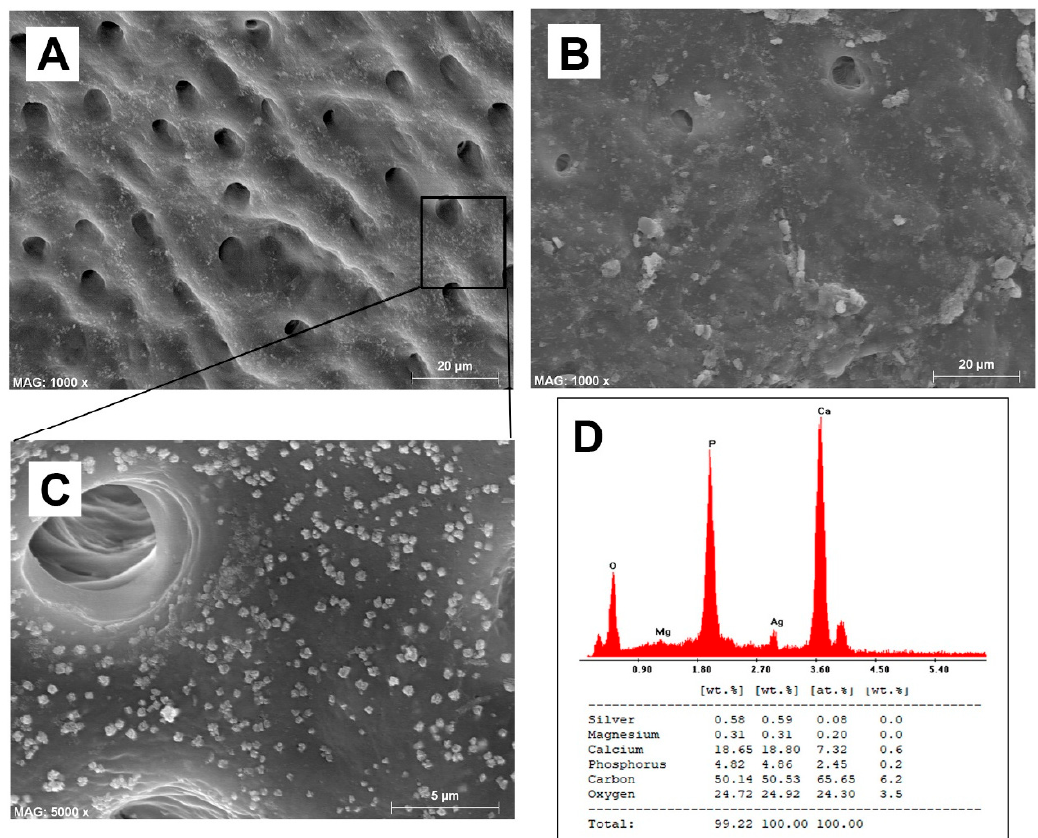
Figure 3. The effect of BioAKT on the apical part of the root canal dentin; the smear layer was well removed and most of the dentinal tubules exposed. ( B ) Note the effect of EDTA on the apical part of the root canal dentin where the smear layer was only partially removed, leaving most of the dentinal tubules still obliterated. ( C ) Higher magnification of image ( A ) where possible to observe the presence of nanometric mineral precipitations on dentin surface. ( D ) EDS analysis confirmed that the mineral clusters observed in image ( C ) contained calcium, phosphorous, magnesium and silver.